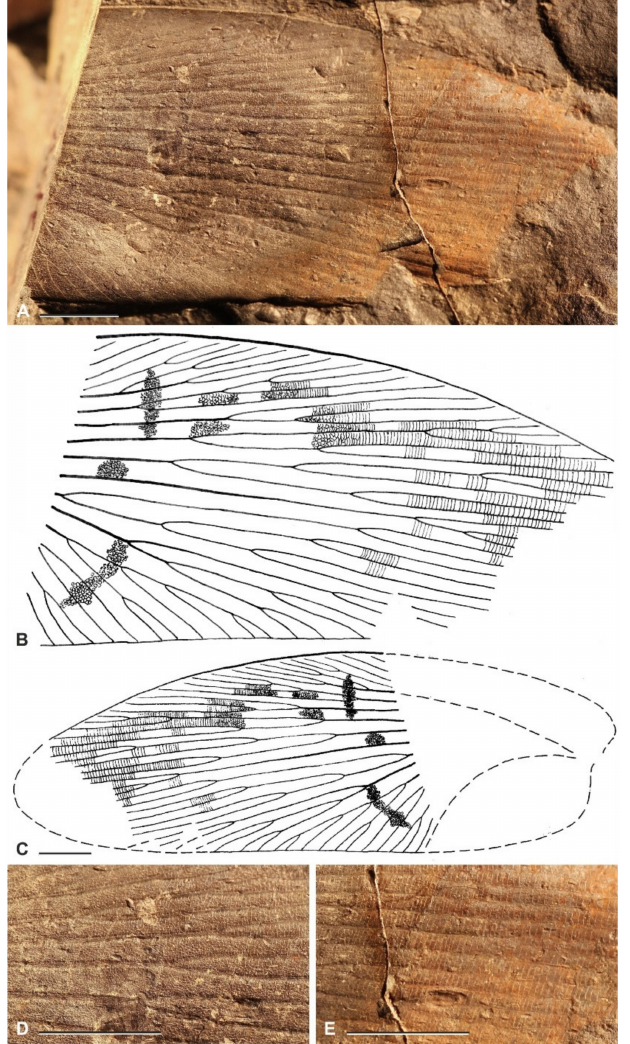
Figure 12. ( A – E ) Progonoblattina helvetica (Heer, 1864): ( A , B )—specimen ‘ Anthracoblattina ensifera-gigantea - group’, Belahmira et al., (2019); Tanamert; CDUE TaI-13d-25; preserved size 38 × 19 mm; ( C )—the same, reconstructed length 60 mm; ( D )—cross-venation in the areas of Sc and R; ( E )—cross-venation in the areas of R and M near wing tip; scale bars 5 mm; photo: L. Puschmann, drawing: A.